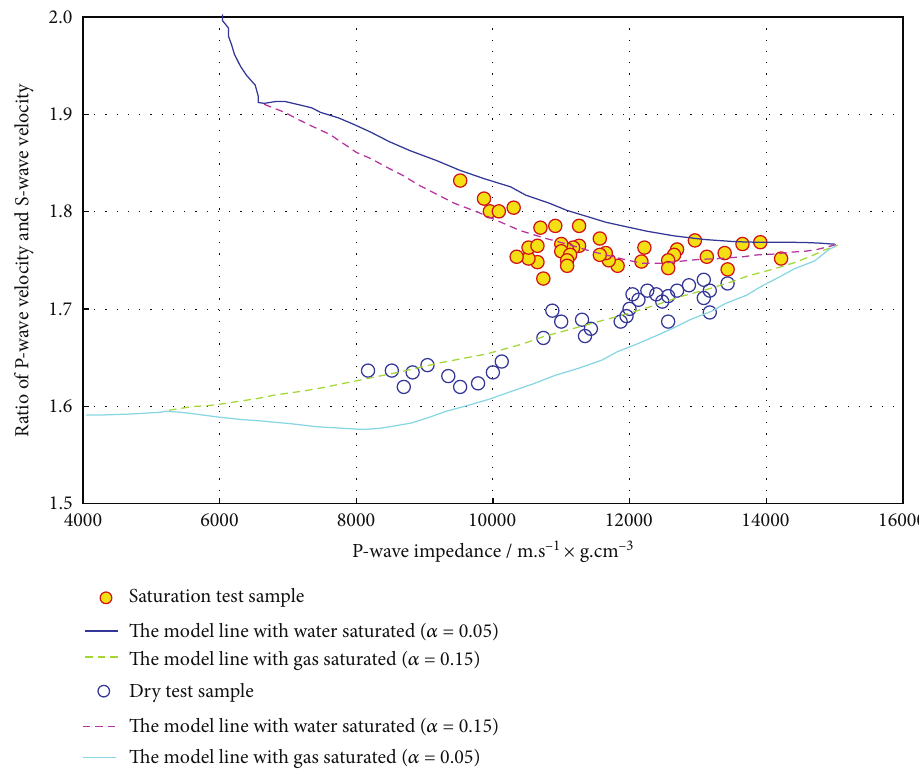
Figure 12: The Baikouquan sandy conglomerate reservoirs relation between P-wave impedance and the ratio of P-wave and S-wave